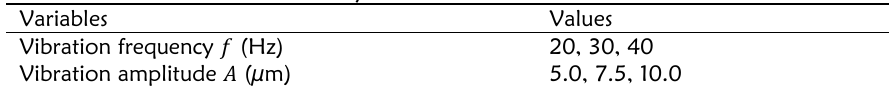
Table 5: Boundary conditions for first series simulation Variables Values